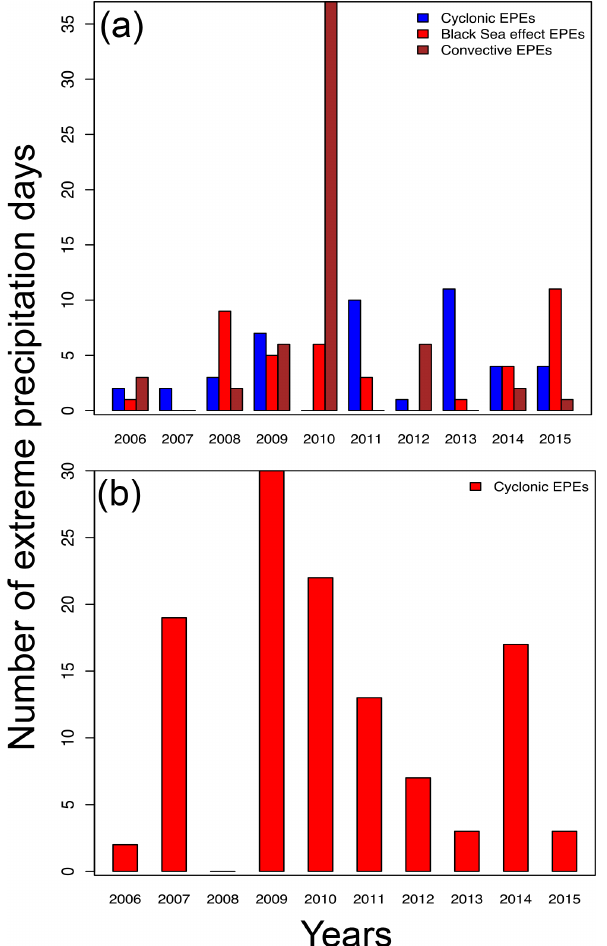
Figure 9. Annual distribution of the total counts of EPEs as well as precipitation characteristics for (a) Marmara in autumn and (b) the Aegean in winter months.